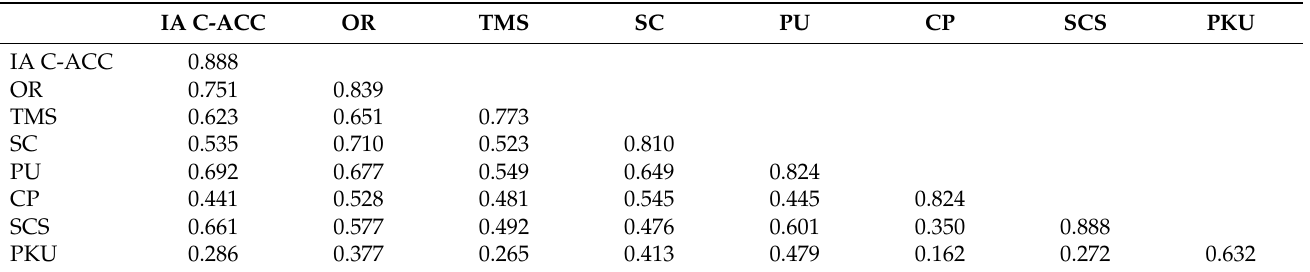
Table 4. The AVE square root (Fornell-Larcker criterion).